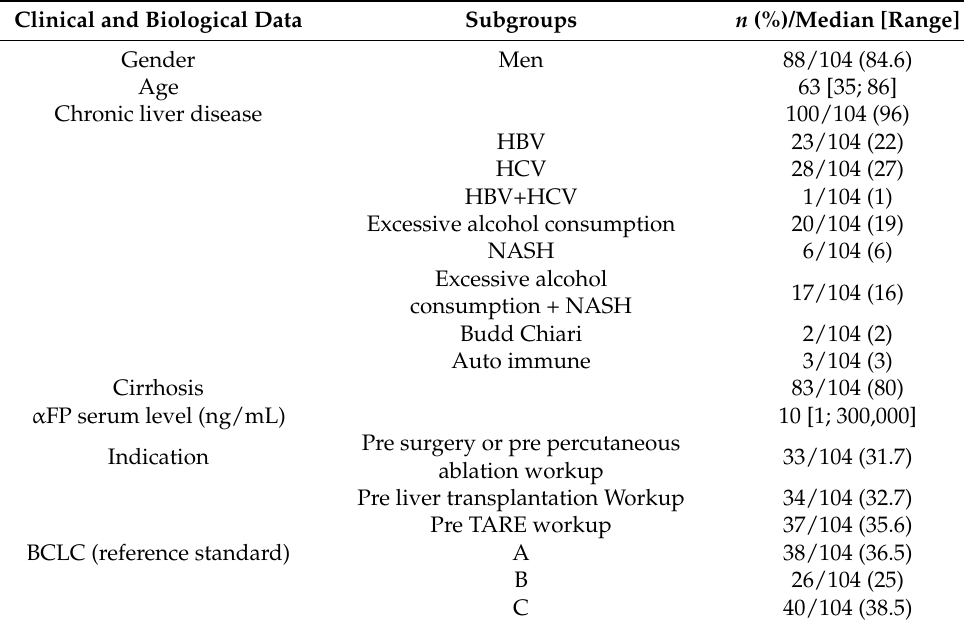
Table 1. Patients and tumor features including clinical and biological data. Clinical and Biological